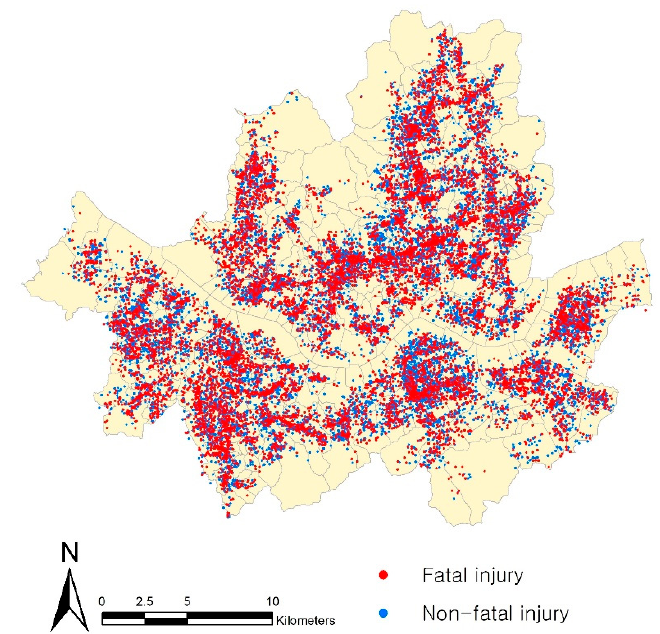
Figure 1. Spatial distribution of pedestrian-vehicle crashes in Seoul.